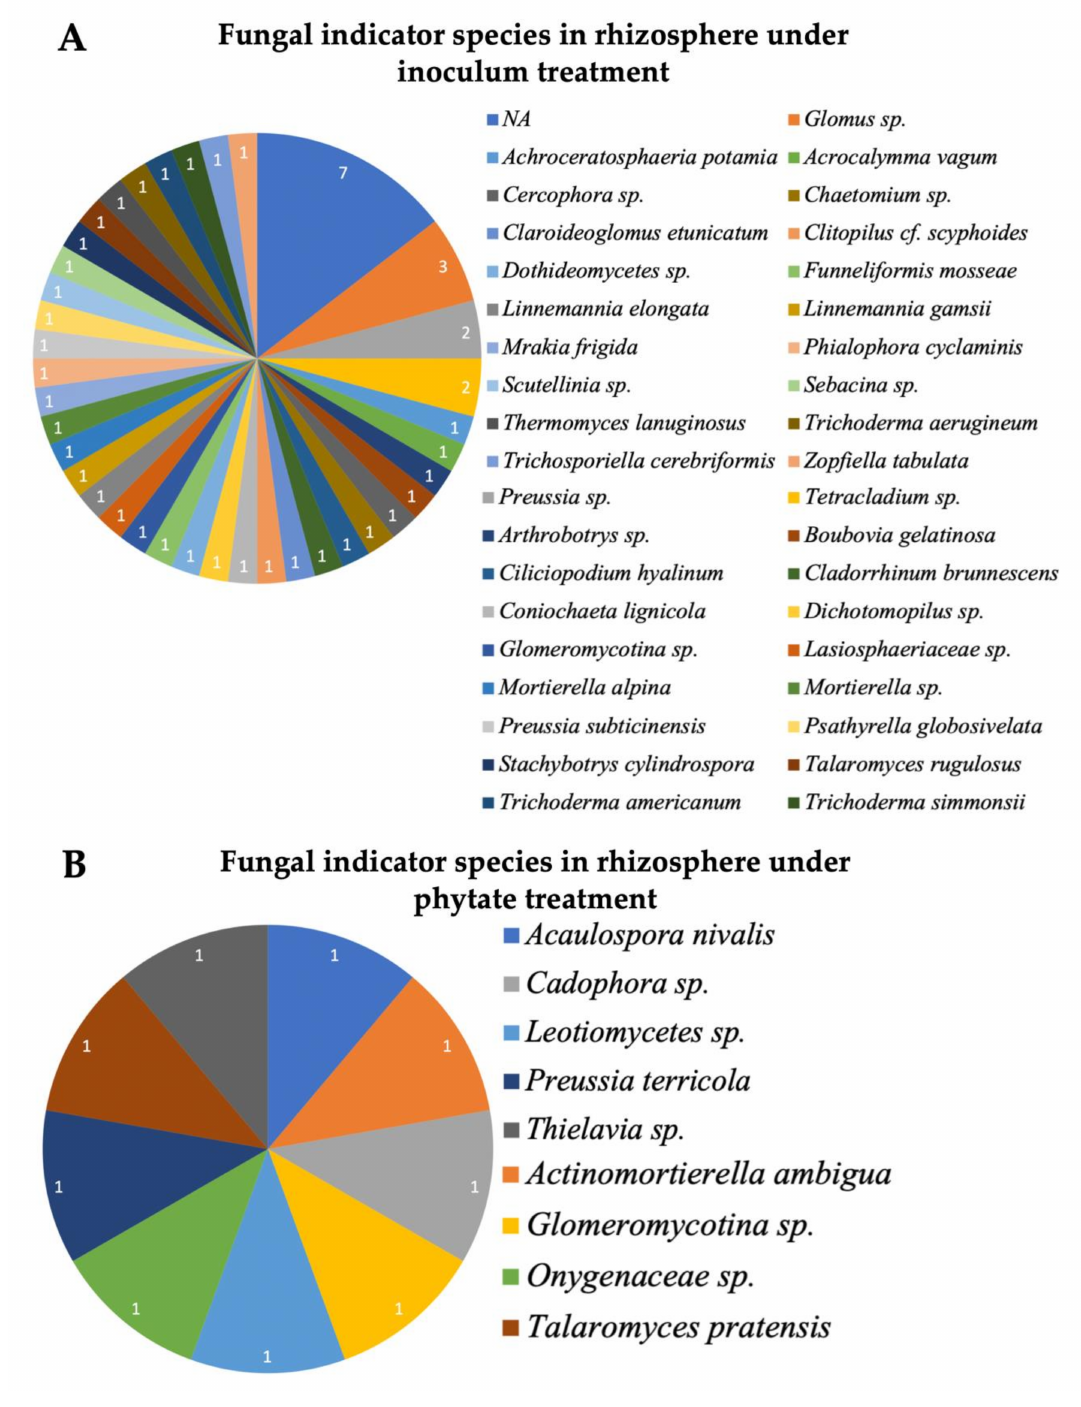
Figure 4. Fungal indicator species of soybean microbiome at the genus level. The most representative species of soybean microbiome were identified through indicator species analysis. Fungal indicator species in rhizosphere biotope under inoculum treatment ( A ) and under phytate treatment ( B ). The number of ASVs is indicated by the number within each